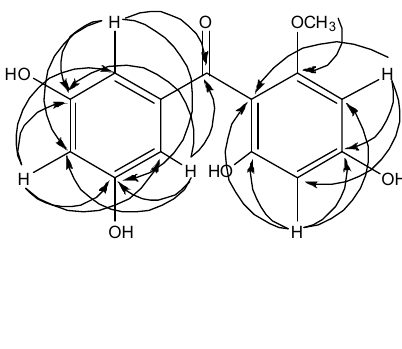
Figure 4. 2 J , 3 J and 4 J HMBC correlations between protons and carbons in compound 2